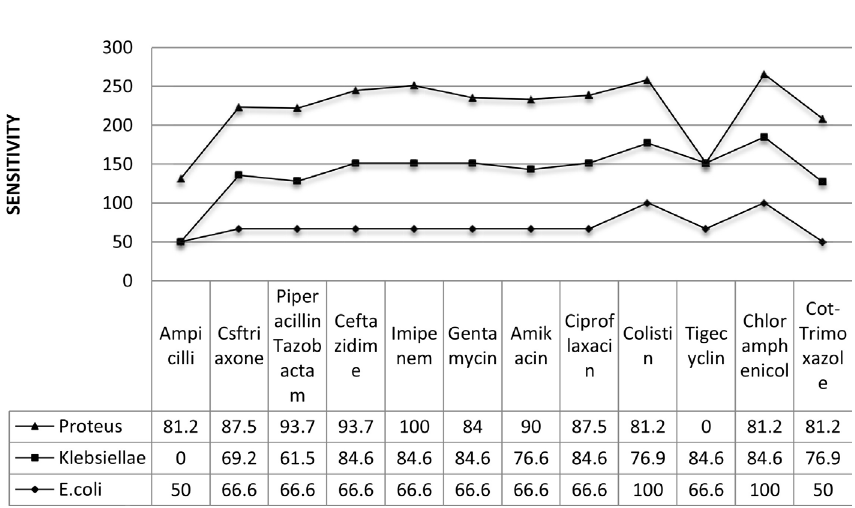
Fig. 4. Antibiotic susceptibility pattern of Enterobacteriaceae ( E.coli, Klebsiellae, Proteus )